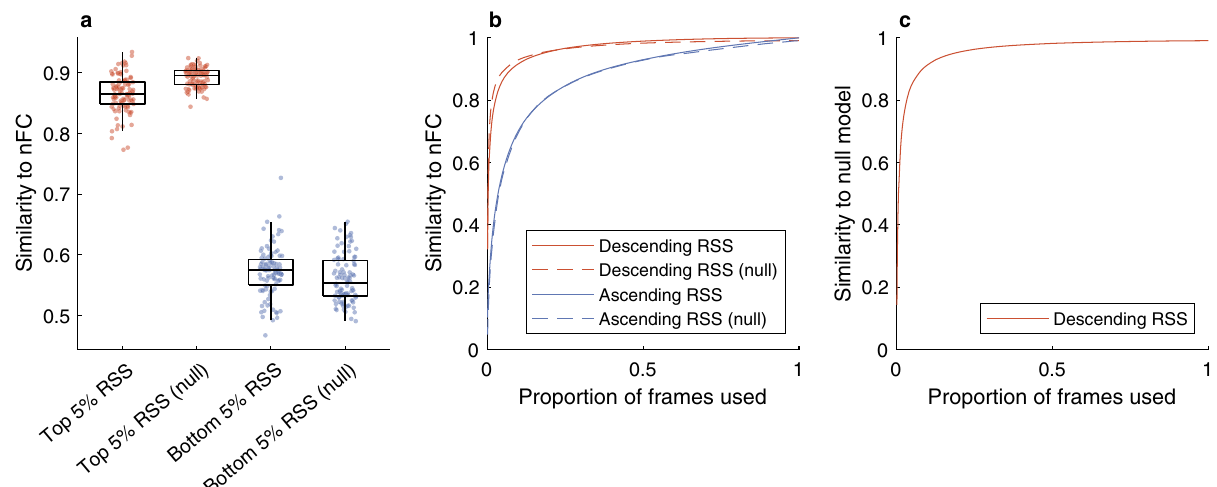
Fig. 3 The static Gaussian null model can reproduce the strong correlation between high-amplitude co fl uctuation patterns and the nFC. a Only a small fraction of frames exhibiting the largest co fl uctuations root-sum-of-squares (RSS) are required to explain most of the nFC variance. The similarity is computed as the Pearson correlation coef fi cient between the nFC and the average FC estimated from the top and bottom 5% of the total frames. Each point corresponds to one of 100 unrelated subjects from the Human Connectome Project (HCP) dataset, with boxes indicating the quartiles and whiskers length speci fi ed as 1.5 times the interquartile range. b The same results hold more generally when the frames are ordered according to the corresponding RSS amplitude, either in descending or ascending order. Here, the curves represent the average similarity over 100 subjects. c The fi ndings do not depend on the timing of the high-amplitude RSS events: the top frames generated by the null model exhibit high similarity to the top frames of the real HCP data, which occur at different